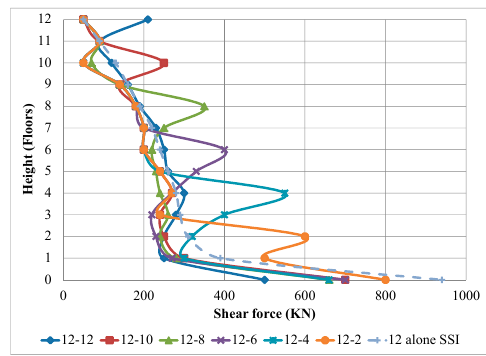
Figure 13. Shear force in the tall building in the case of the two adjacent buildings with SSI.